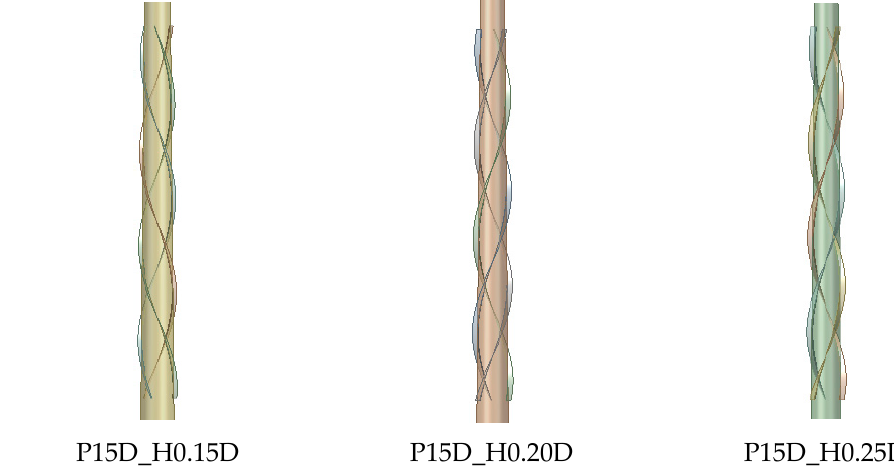
Figure 23. Different side plate heights of the high-mast light pole with spiral side plates.